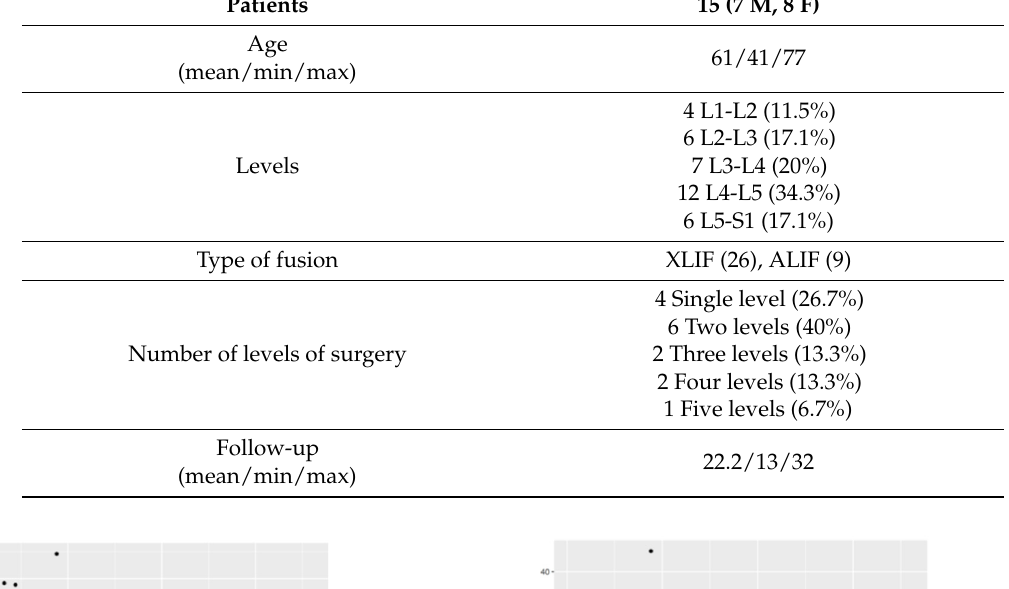
Table 1. Descriptive Data.